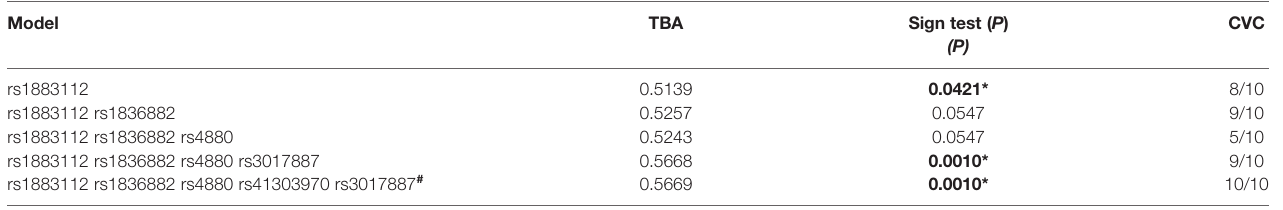
TABLE 5 | Generalized multifactor dimensionality reduction models of multi-genes of hepatitis B virus-induced liver disease.